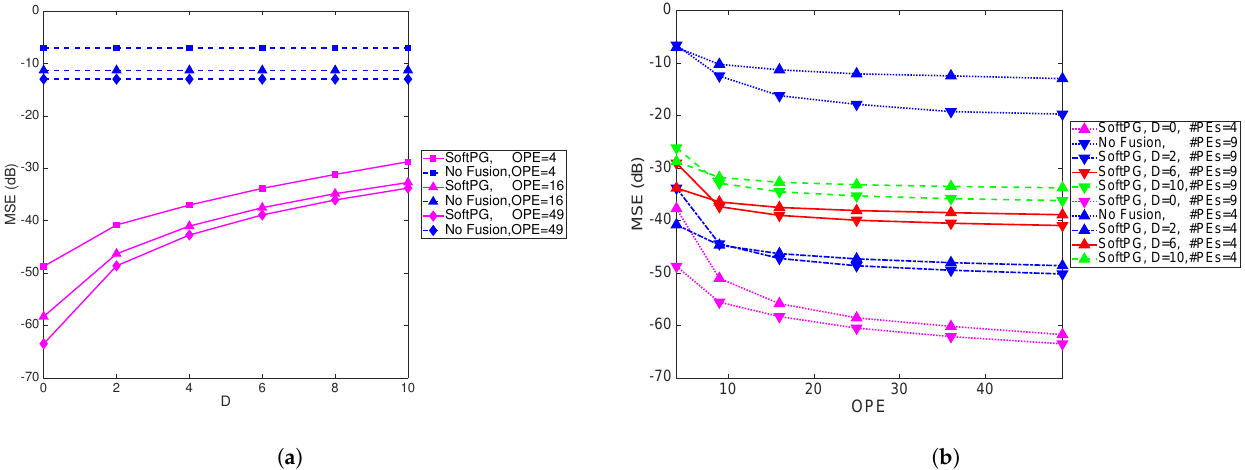
Figure 7. ( a ) MSE as a function of delay for different number of observations per PE (OPE). The size of the state vectors is M = 20. ( b ) MSE as a function of the number of observations per PE. Two cases are shown, one with 4 PEs and another with 9. M =